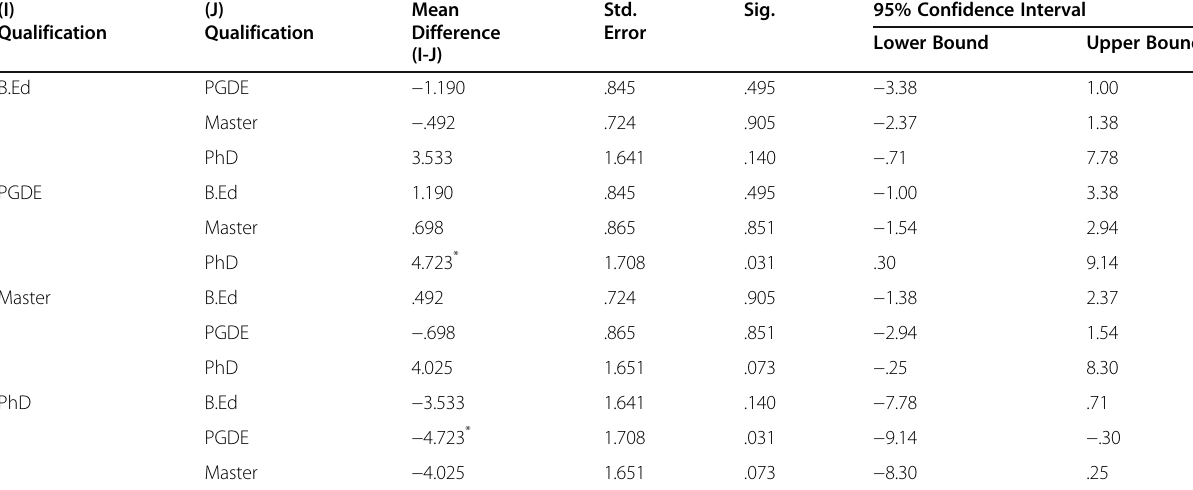
Table 11 Tukey HSD Post-hoc Test on Bhutanese Science Teachers ’ Perceptions of the NOS (I) Qualification